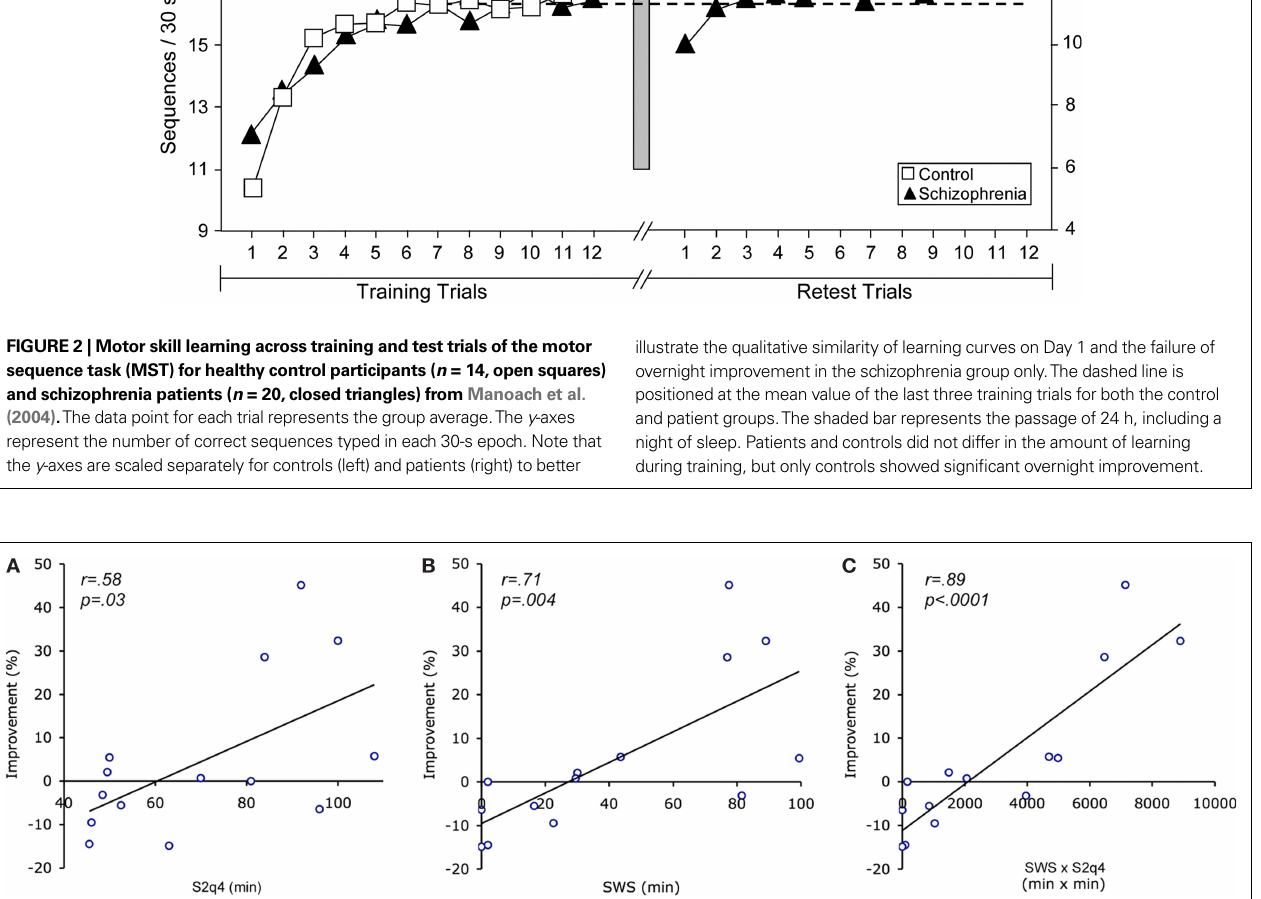
FIGURE 3 | Correlation of overnight improvement with minutes spent in slow wave sleep (SWS) and stage 2 sleep in the last quartile of the night (S2q4) in schizophrenia patients. (A) Correlation with S2q4 sleep; (B) Correlation with SWS; (C) Correlation with the product of SWS and S2q4 sleep (SWS x